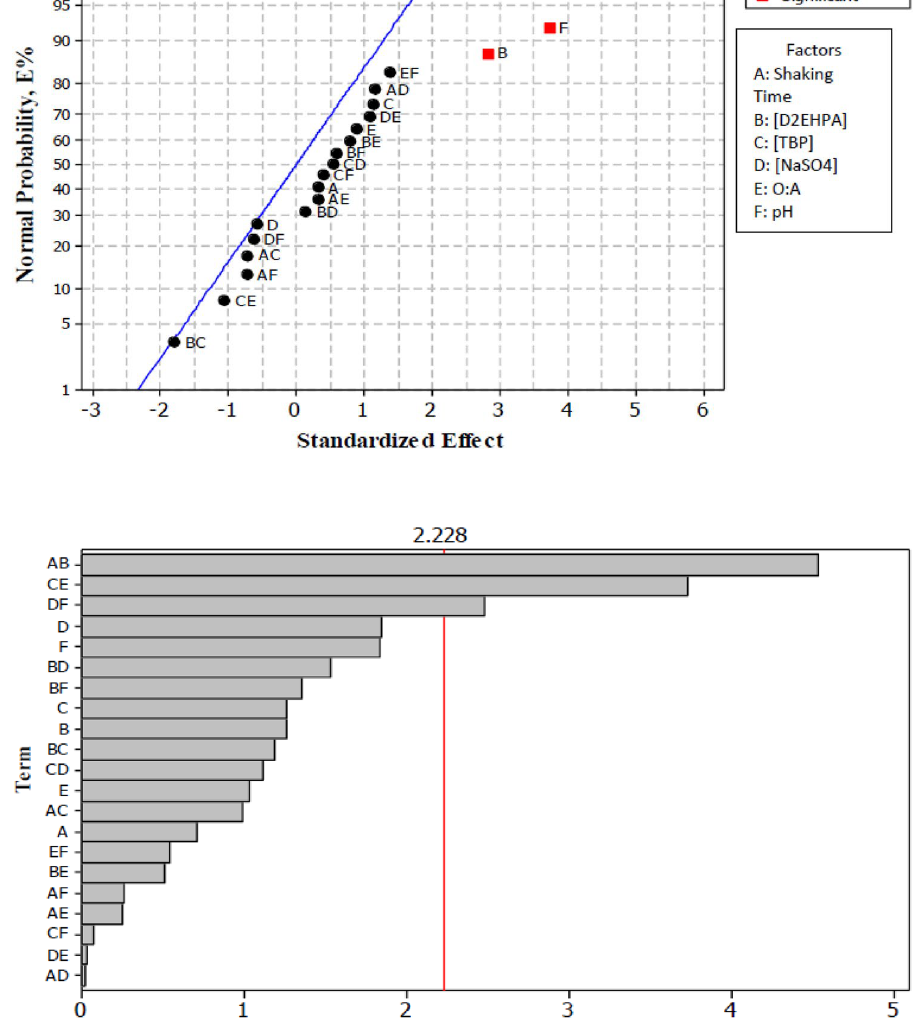
Fig. 5 Normal probability against standardized effects for Cd(II)